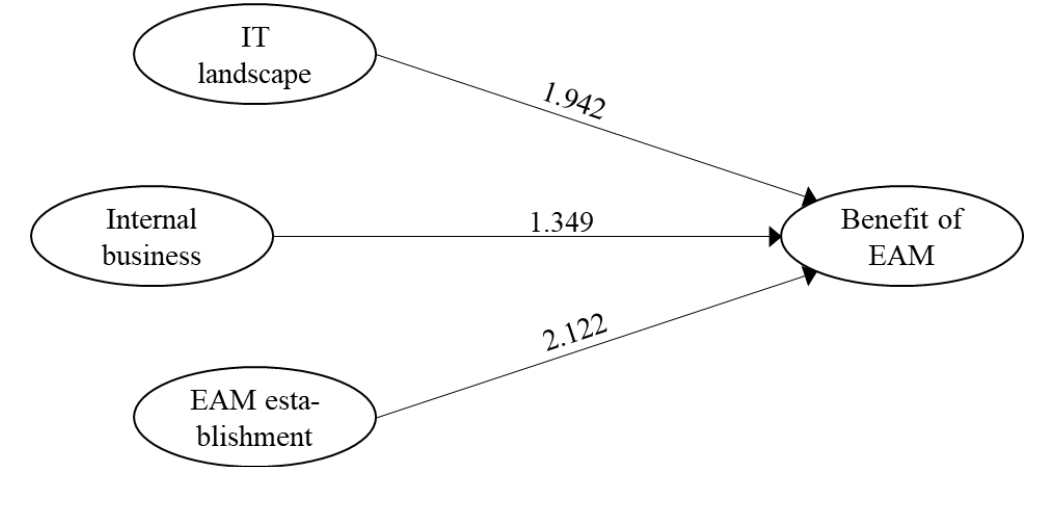
Figure 4. Structural equation model with coefficients of the